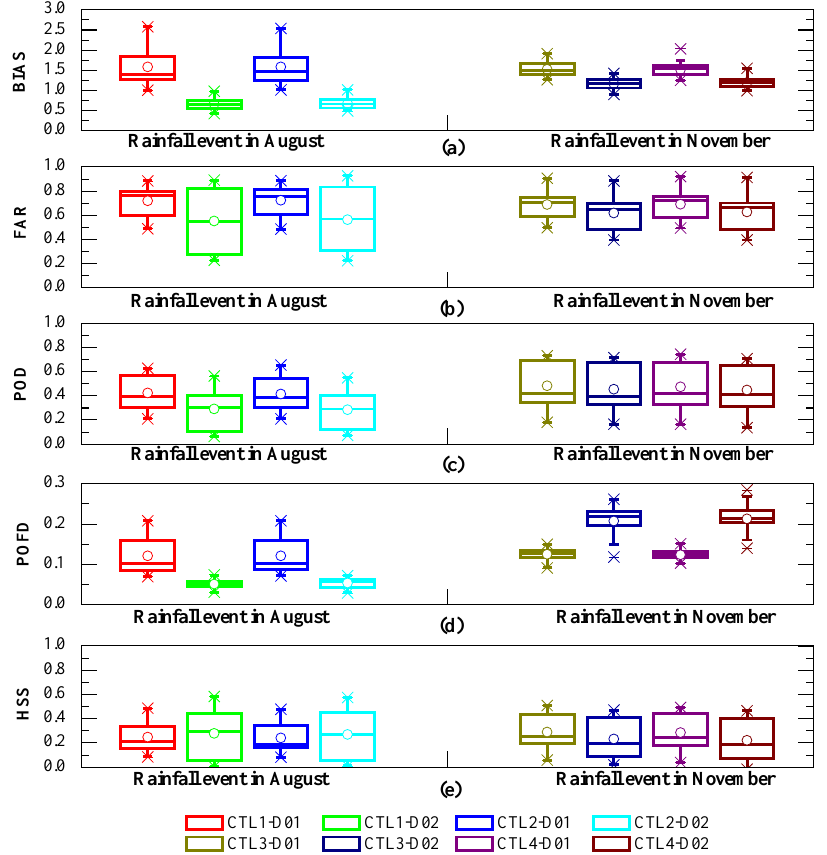
Figure 4. Box plots * of evaluation scores BIAS ( a ), FAR ( b ), POD ( c ), POFD ( d ), and HSS ( e ) for hourly precipitation (exceeding 0.1 mm/hour) simulated by the WRF CTL experiments and estimated by the merged Climate Prediction Center Morphing technique (CMORPH) data. * The lower and upper edges of the central box represent the first and third quartiles (25% and 75%, respectively), and the band and the circle inside the box represent the 50 th percentiles and the mean values, respectively. The ends of the outliers represent the minimum and maximum values of the score distributions. The asterisks represent several possible alternative values.